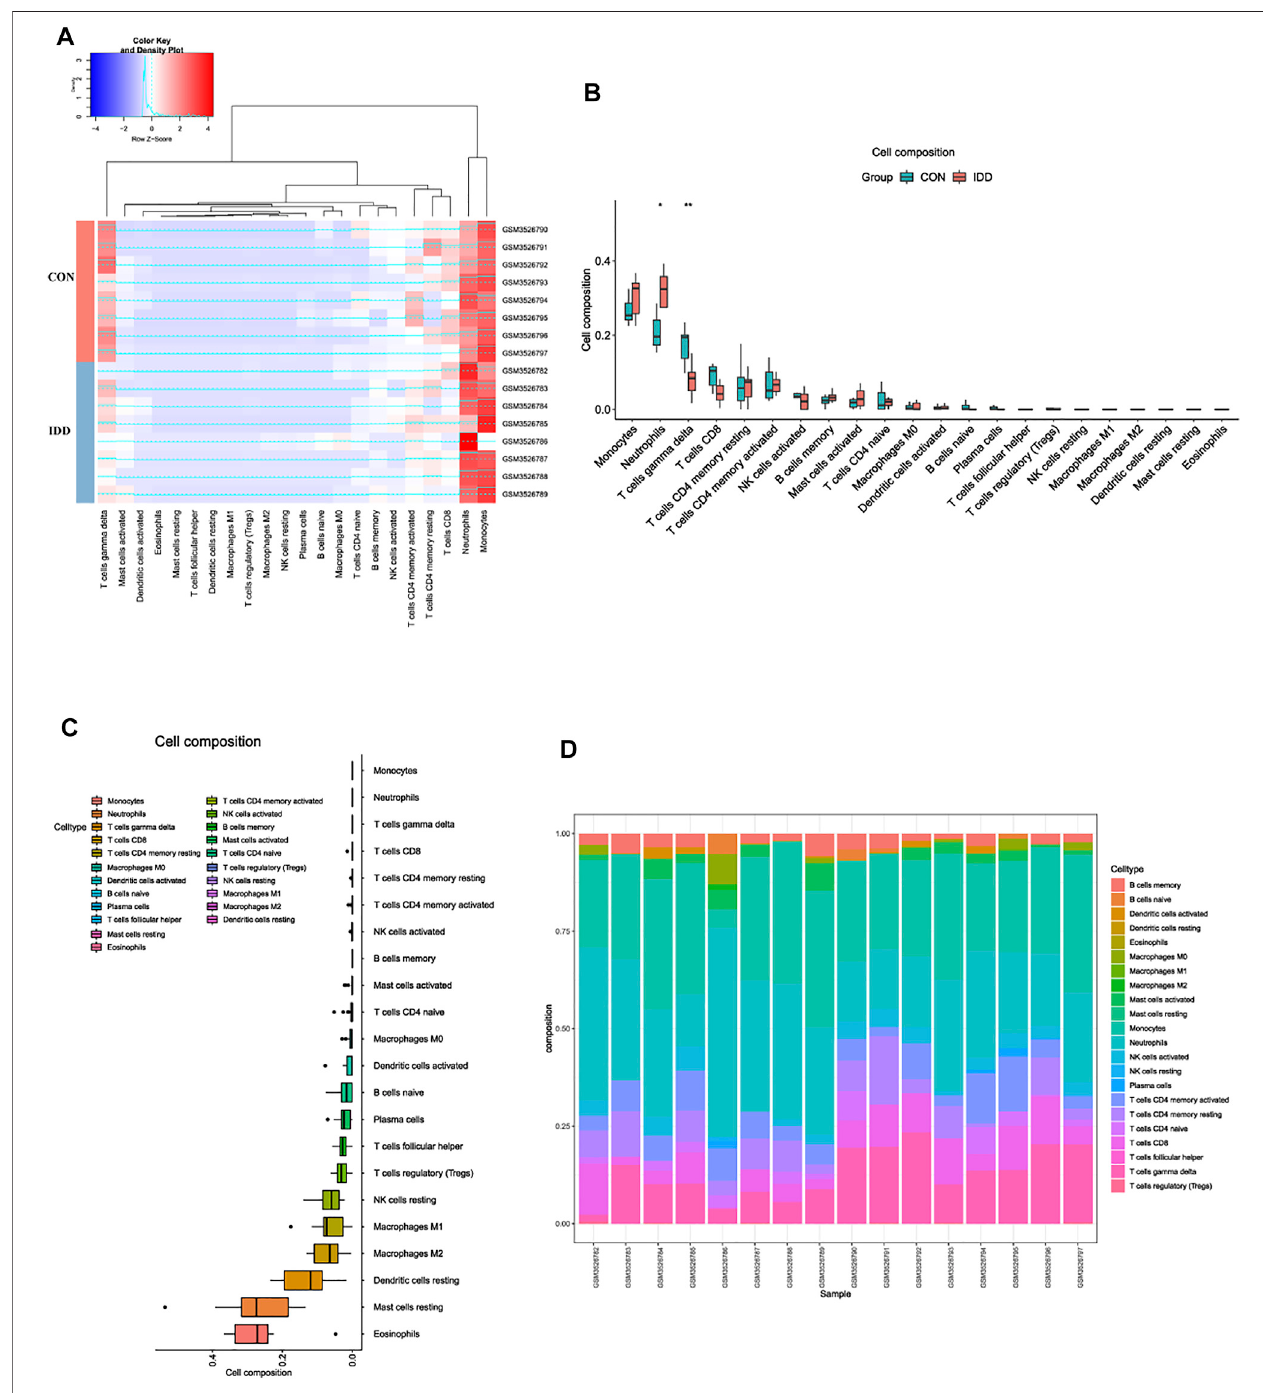
FIGURE3| AnalysisofimmunelandscapeassociatedwithIDDinbloodtissue. (A) heatmapdisplayingthedistributionof22typesofimmunecellsinbloodtissueof normaland IDD patientsinGSE124272. (B) therelationship ofimmunein fi ltration levels between normal and IDDpatients. (C) boxplotdisplayingthewholecomposition of immune cells in these patients. (D) pile-up histogram showing composition of immune cells in each sample.